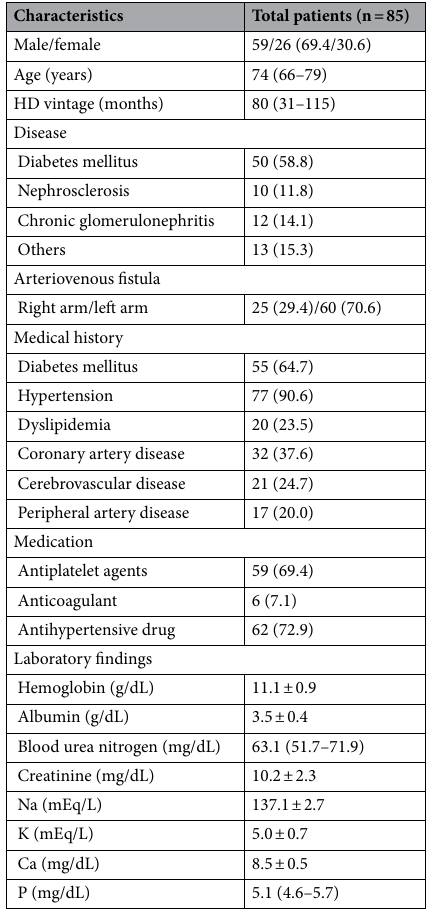
Table 4. Characteristics of the patients. Categorical data are presented as number (%), continuous data are presented as mean ± standard deviation or median and interquartile range. HD hemodialysis, Na serum sodium concentration, K serum potassium concentration, Ca serum calcium concentration, P serum inorganic phosphate